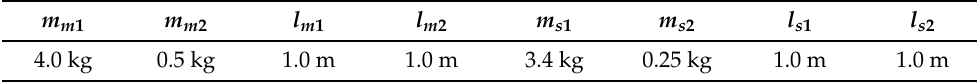
Table 1. Physical parameters of the teleoperation